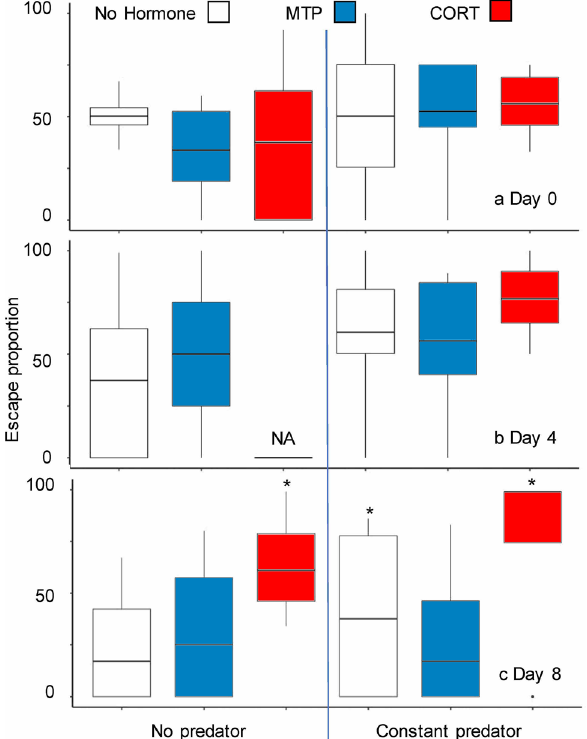
Figure 2. Treatment with corticosterone (CORT) or constant exposure to nonlethal predators increased the ability of wood frog tadpoles to escape predator attack. Shown are boxplots (median and interquartile range) of percentage of Anax attacks from which tadpoles successfully escaped in each treatment combination ( n = 4 replicates) on Day 0 ( a ), Day 4 ( b ), and Day 8 ( c ). NA indicates a treatment in which no data were recorded due to technical problems. Asterisks indicate significant differences compared to the No predator/No hormone treatment ( P <